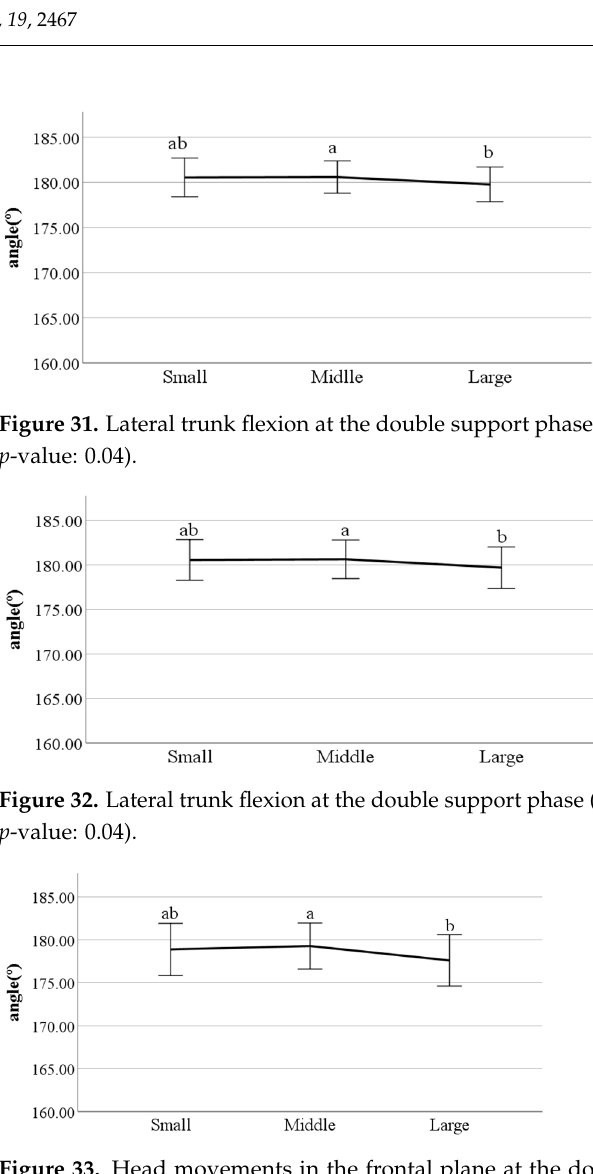
Figure 30. Mean flexion of the spinal column in the sagittal plane (F value: 4.29, DF: 2, p -value: 0.02).